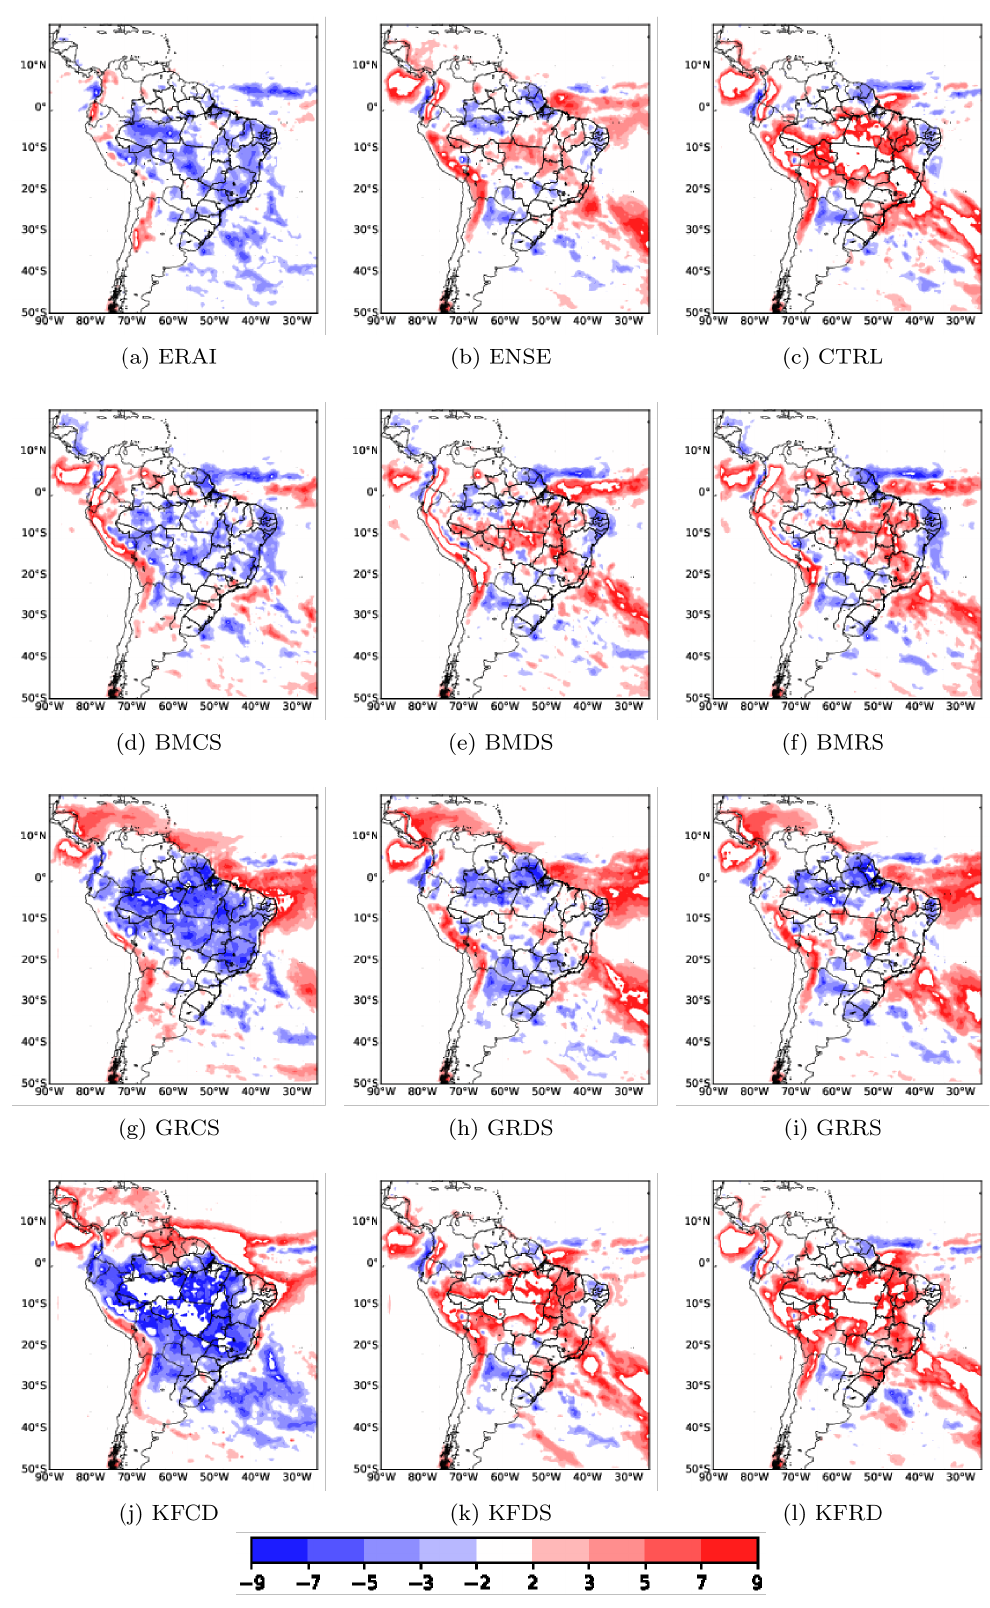
Figure 7. Deviations of simulated precipitation fields to the observational reference (TRMM) for